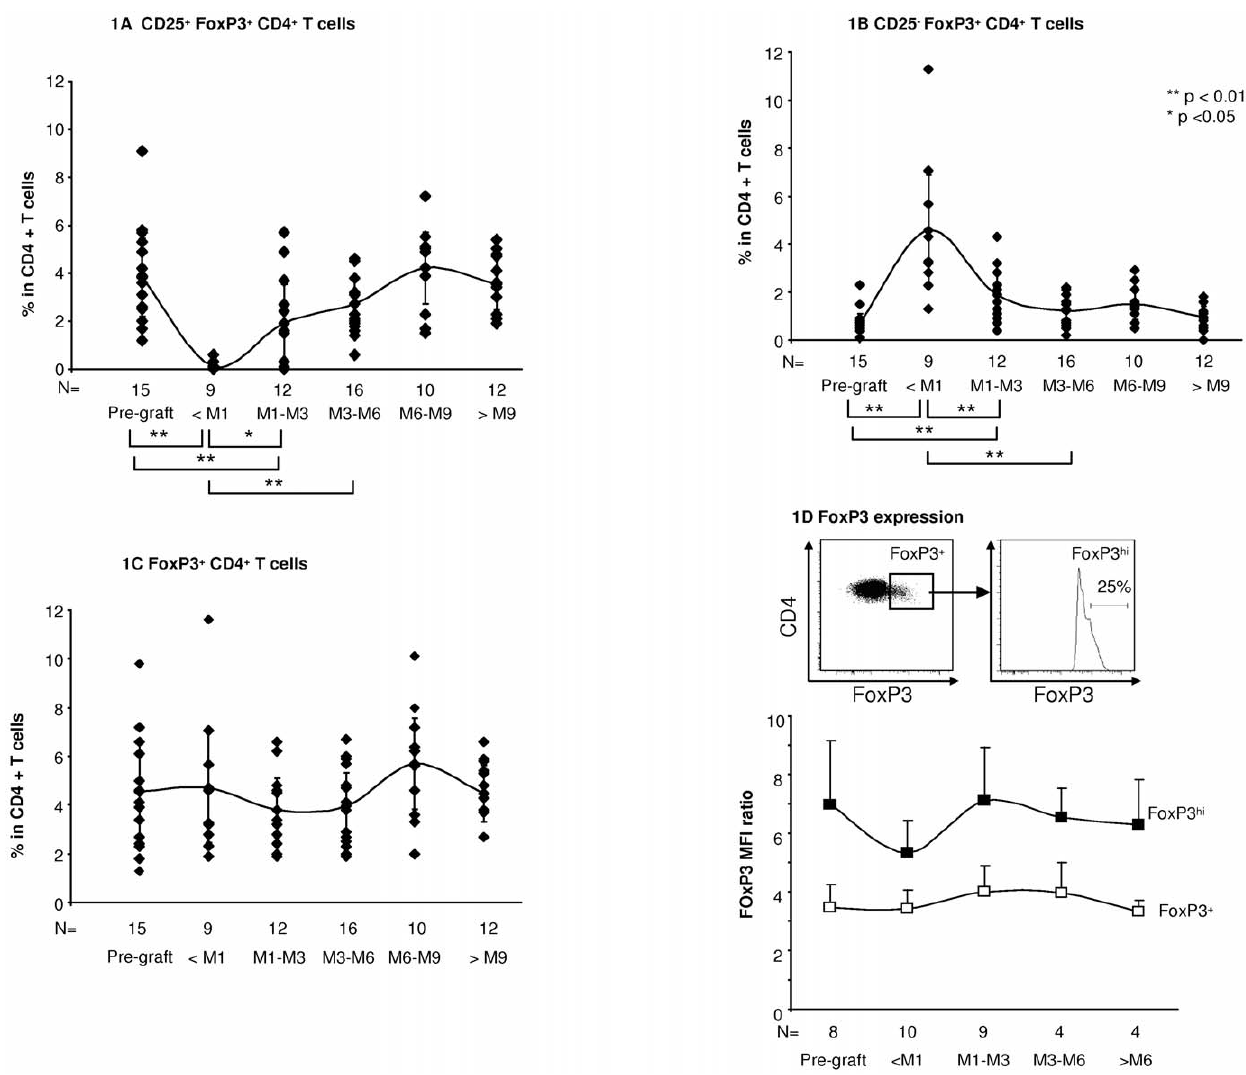
Figure 1. No significant effect of a blocking anti-CD25 antibody on the proportion of human FoxP3 + CD4 T cells in vivo. The proportion of CD25 + FoxP3 + ( 1A ), CD25 2 FoxP3 + ( 1B ) and total FoxP3 + cells ( 1C ) among CD4 T lymphocytes was determined before liver grafting and basiliximab injection, and for more than 9 months thereafter; data are means (curves) and SEM at the different time points. In 1D , the FoxP3 + /FoxP3 2 and FoxP3 hi / FoxP3 2 MFI ratios were used to compare the level of intracellular FoxP3 expression (see Methods). Means and SEM are shown. The Mann Whitney test was used for statistical analysis. The number of patients tested at each time point is indicated. Only statistically significant differences are indicated.